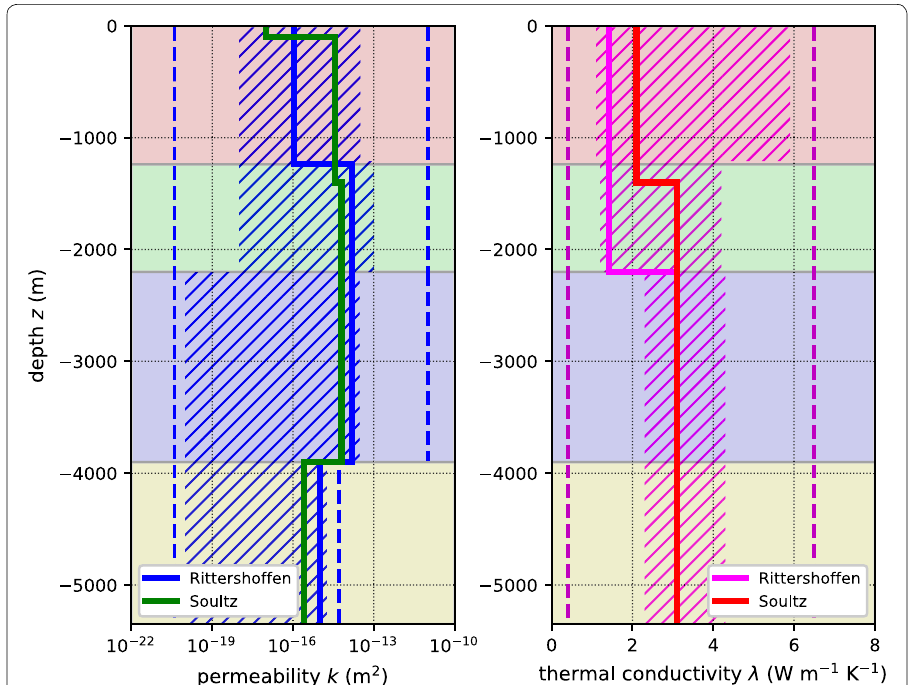
Fig. 4 Comparison of permeability estimated by back analysis (left) and thermal conductivity (right) between Rittershoffen and Soultz-sous-Forêts sites. The shadow zones correspond to the range of experimental values (permeabilities in green, and thermal conductivity in red) (see Table 1). The dashed lines correspond to the prior distributions for the back analysis (see Table 3). Background colors correspond to geological